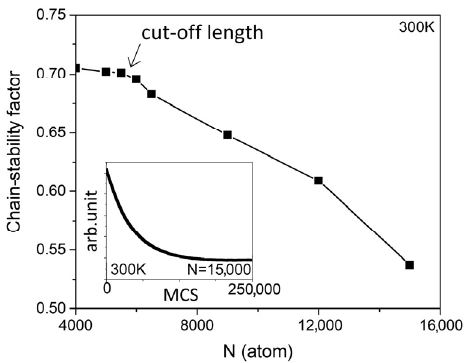
Figure 4. An LCC encapsulated by a (6,4)CNT during heating. The atomic fl uctuations of the LCC depend on the chain length and temperature. ( a ) The LCC consists of 6000 atoms. ( b ) The LCC contains 15,000 atoms.